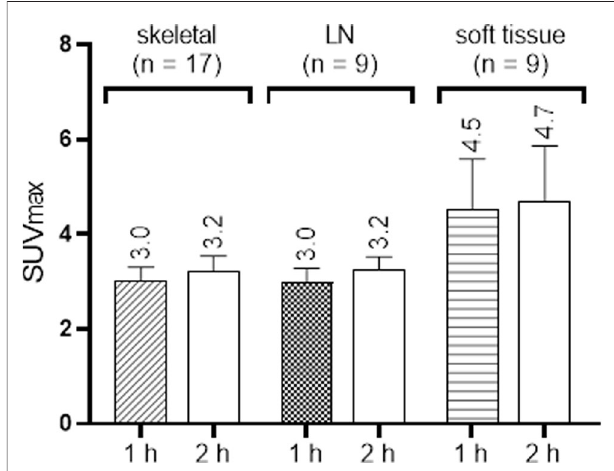
FIGURE 1 | Boxplots of [ 18 F]PSMA-1007 uptake (SUV max ) in different sites 1 and 2 h after injection. Results are presented as